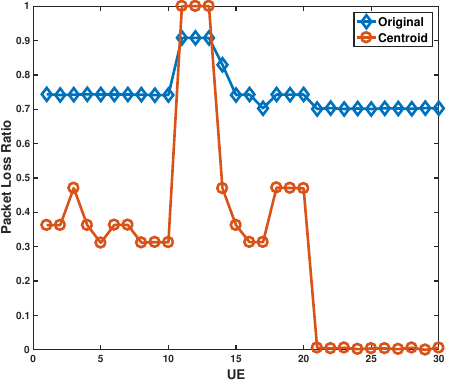
Figure 7. Standard Deviation of Delay Performance vs. Number of UEs Figure 8. Packet Loss Ratio vs. Number of UEs